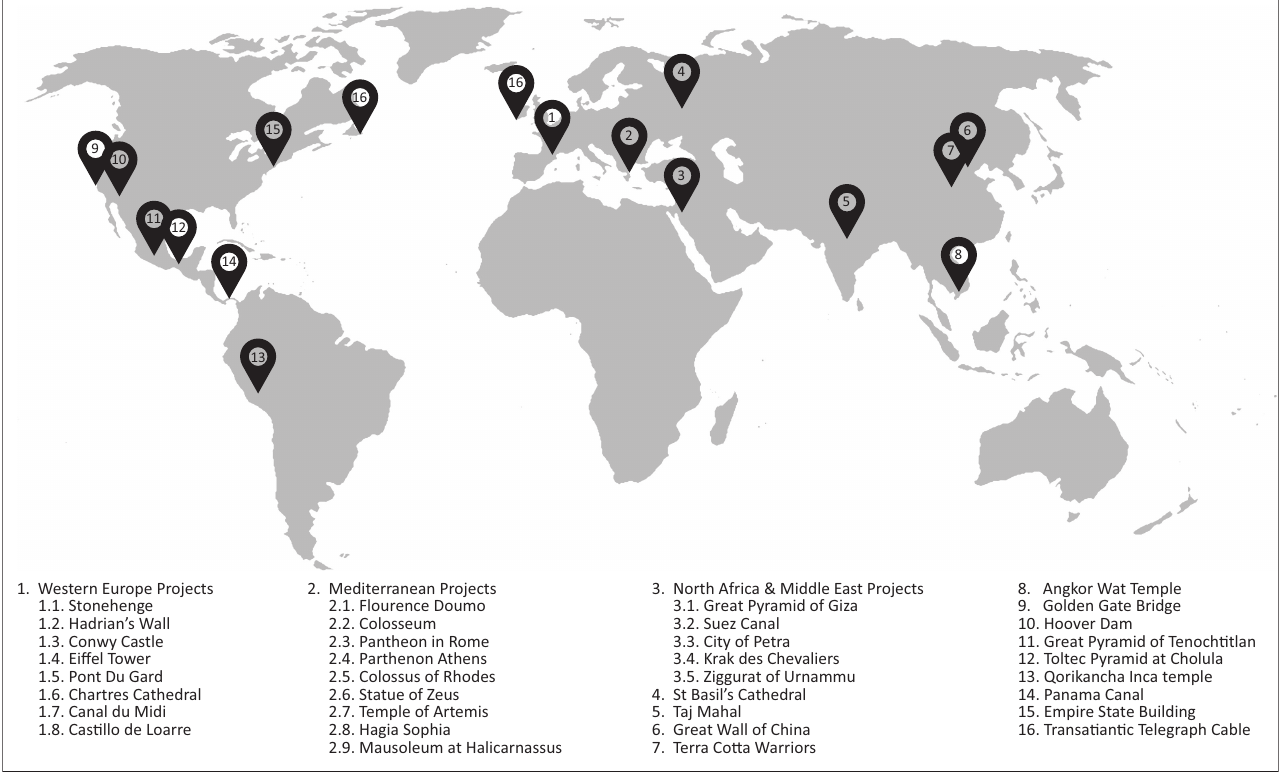
FIGURE 1: Historical map of